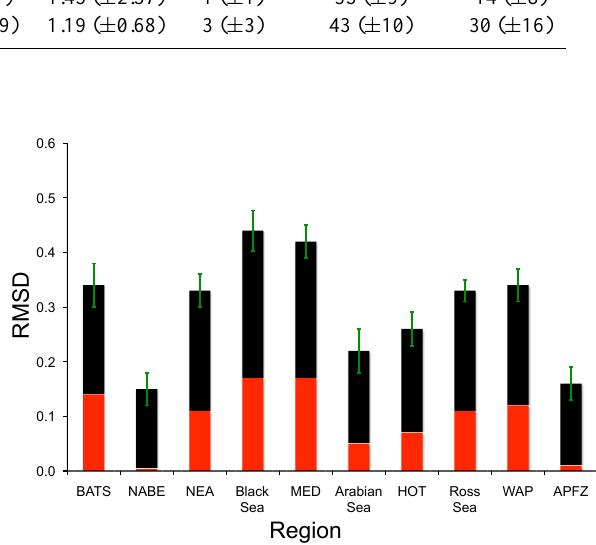
Fig. 2. Average RMSD for all 21 models at each region. Lower val- ues of RMSD are equivalent to higher model skill. Green error bars are 2 × standard error. Red bars represent the maximum reduction in RMSD (increase in model skill) when the uncertainty in both the input variables and in situ NPP measurements are